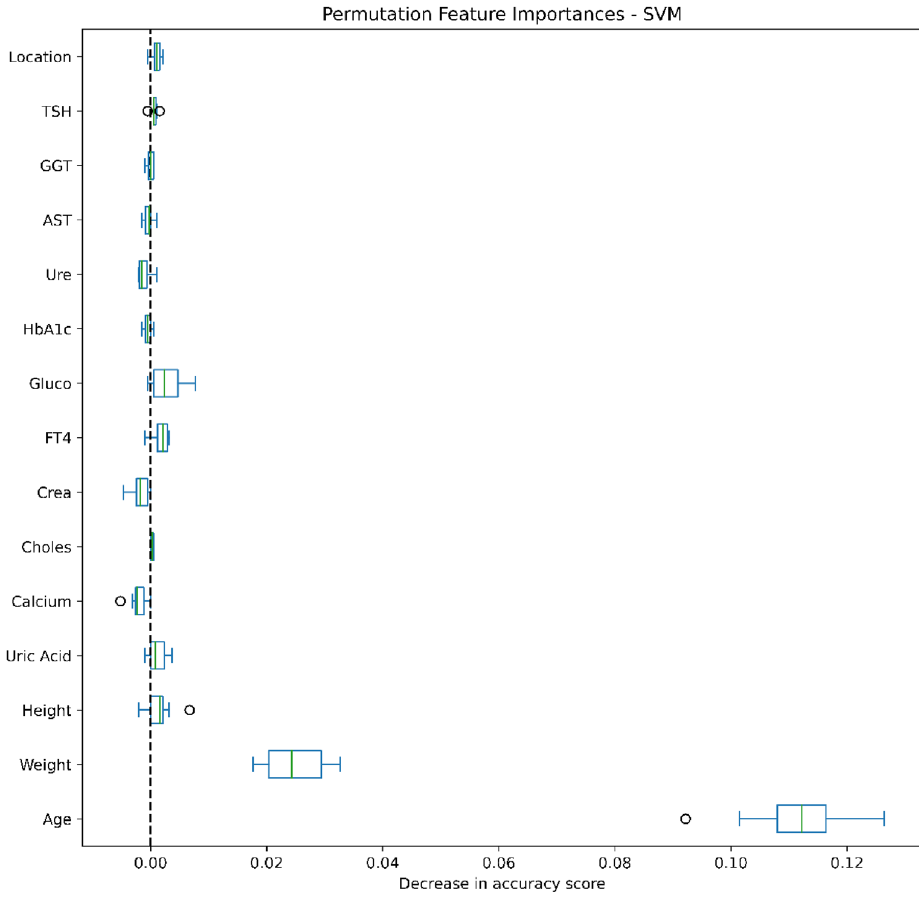
Figure 6. Feature importance for SVM in the first